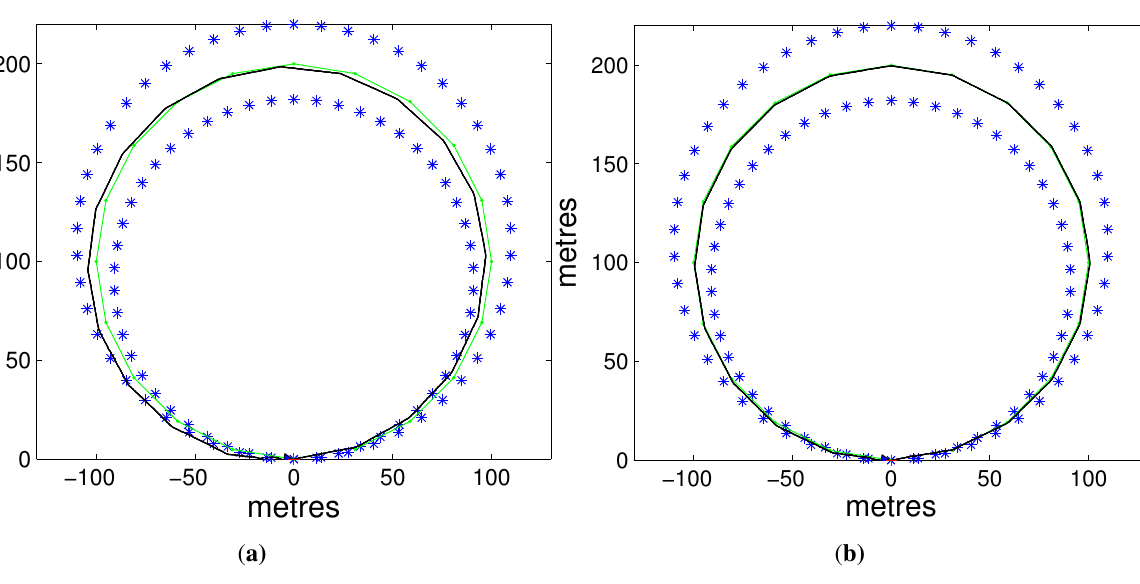
Figure 2. The results of trajectory and landmarks estimated by SEIF ( a ) and iterative SEIF (ISEIF) ( b